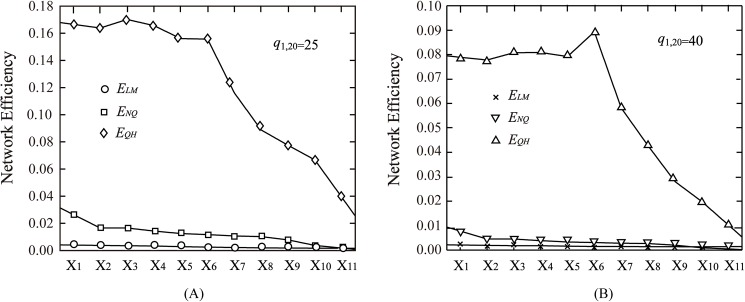
Network efficiency vs network structure.In the case of q1,20 = 25. (B) In the case of q1,20 = 40.